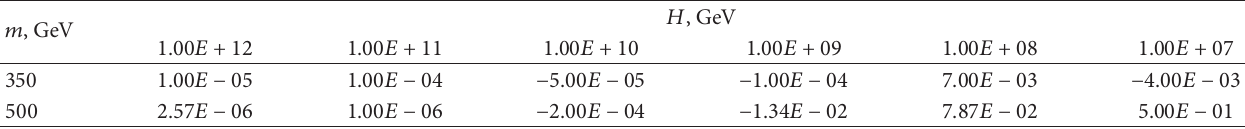
Table 2: The baryon charge 𝐵 contained in the SFC at the time of its decay for different 𝐻 𝐼 and 𝑚 and fixed set of 𝜆 1 = 5 × 10 −2 , 𝛼 = 10 −2 , 𝜆